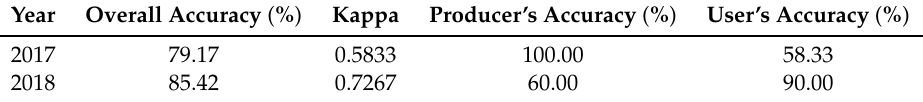
Figure 5. Comparison of field survey data and classification results for ( a ) 2017 and ( b ) 2018. Table 2. Confusion matrix of classification result for aquatic vegetation (compared to field